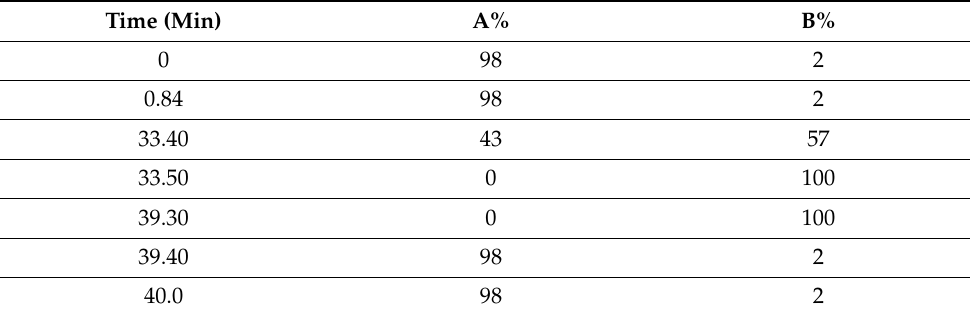
Table 6. Mobile phase program at HPLC analysis of amino